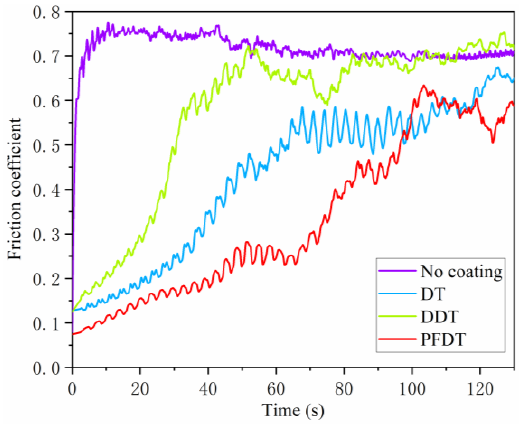
Figure 8. Friction coefficient of SAMs on Ni surface with the friction time .